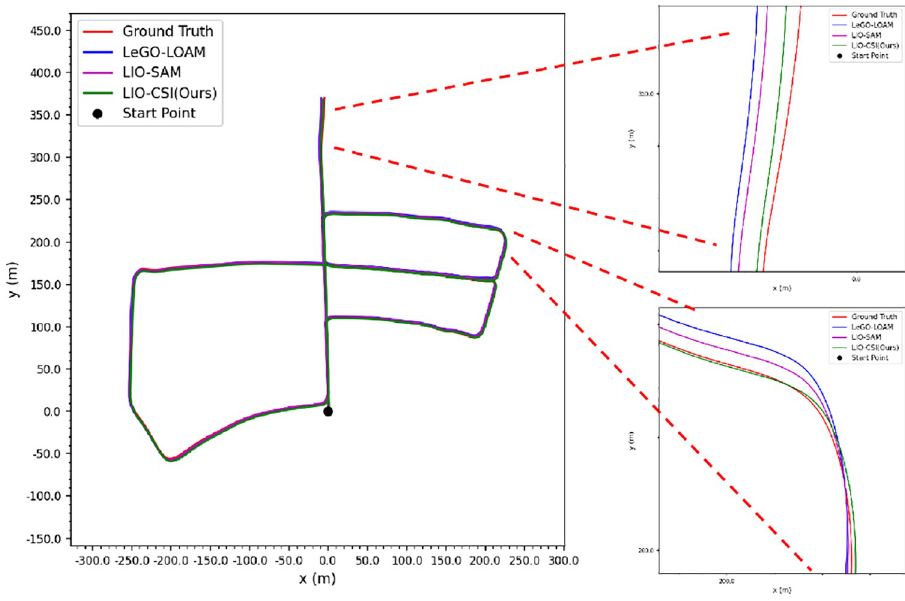
Fig 8. Trajectory comparison on sequence 05 of the KITTI dataset.